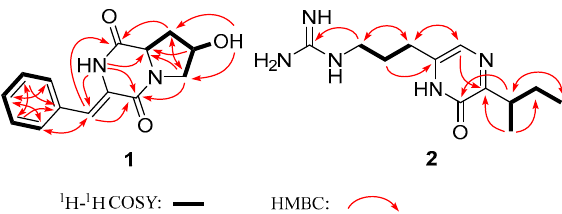
Figure 2. COSY and key HMBC correlations of compounds 1 and 2 .